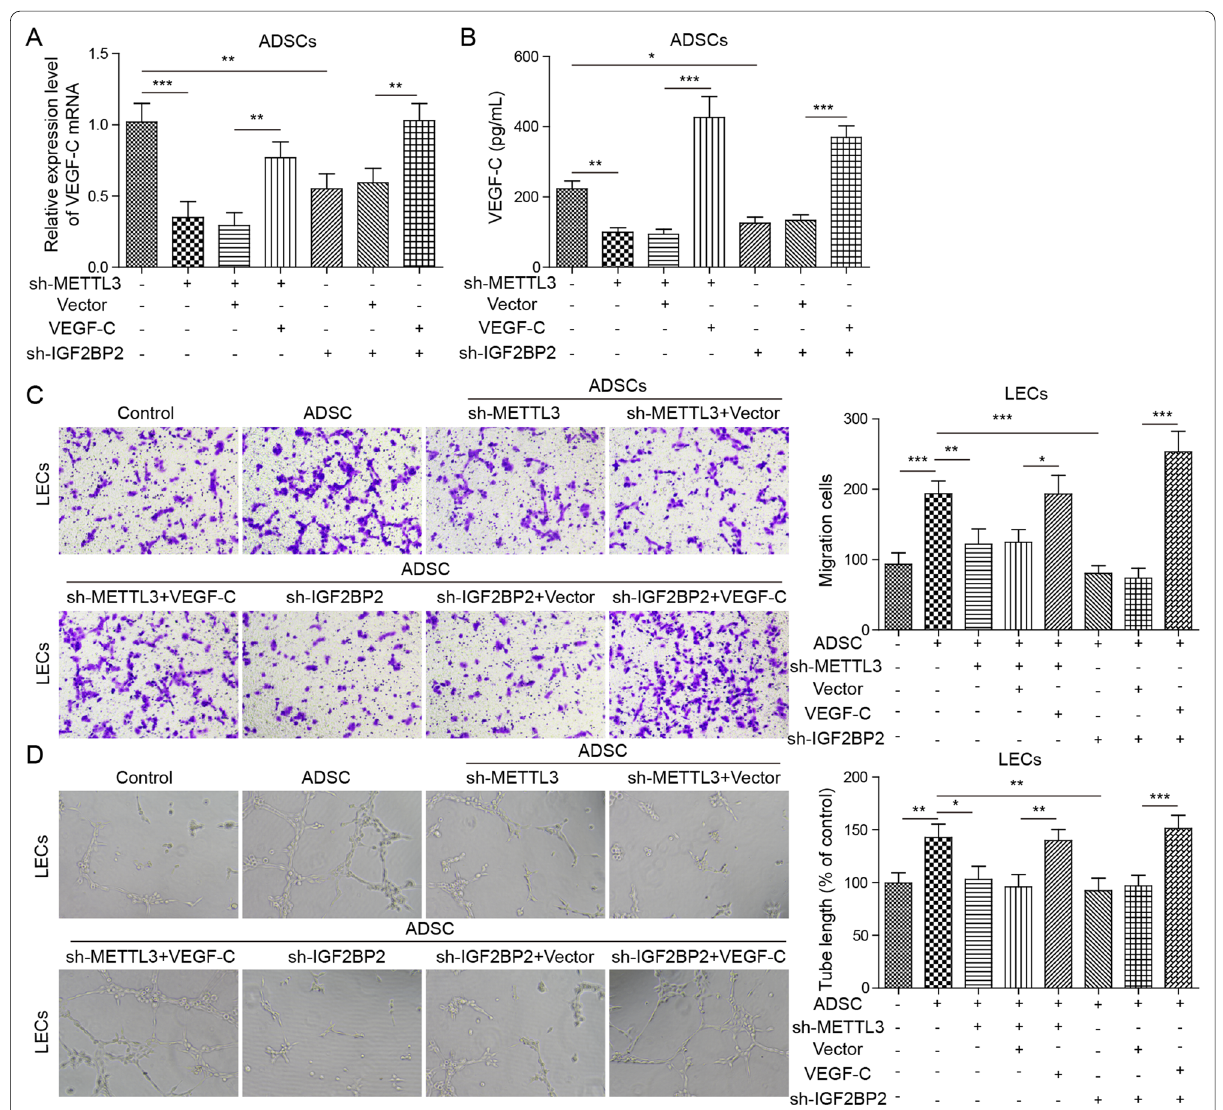
Fig. 4 ADSCs regulate VEGF-C-mediated lymphangiogenesis via the METTL3/IGF2BP2-m 6 A pathway. sh-METTL3 or sh-IGF2BP2 and pcDNA-VEGF-C were cotransfected into ADSCs. sh-NC served as the negative control for sh-METTL3 or sh-IGF2BP2, and the pcDNA-empty vector served as the negative control for pcDNA-VEGF-C plasmids. Subsequently, transfected ADSCs were cocultured with LECs. A RT-qPCR was performed to assess the levels of VEGF-C. B An ELISA was conducted to assess the levels of VEGF-C. C Transwell assays were carried out to evaluate LEC migration. D A tubule formation assay was performed to assess the tubule formation ability of LECs. Data represent the mean of three independent experiments. Error bars represent SD. * P < 0.05, ** P < 0.01 or *** P <